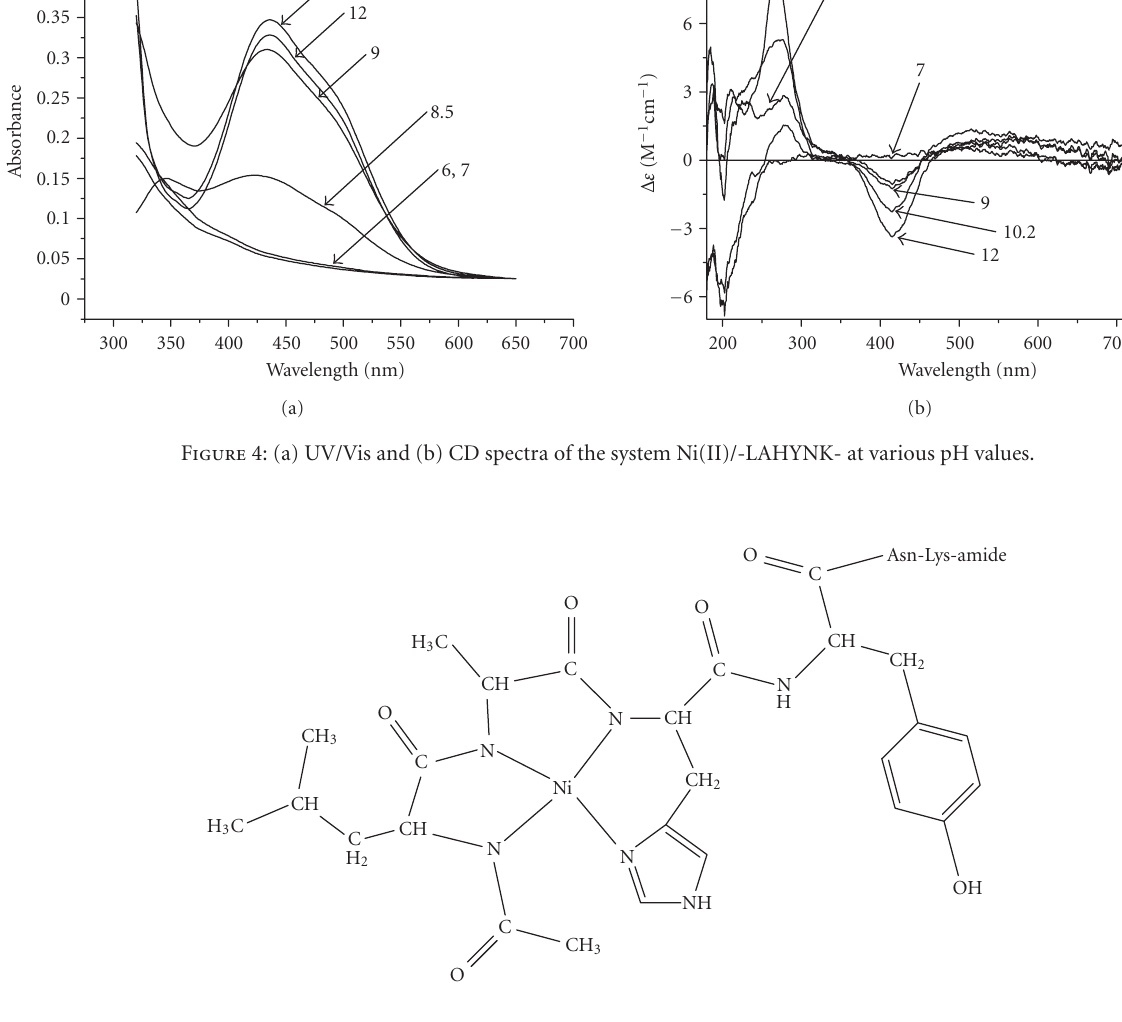
Scheme 3: Possible structure of NiH − 1